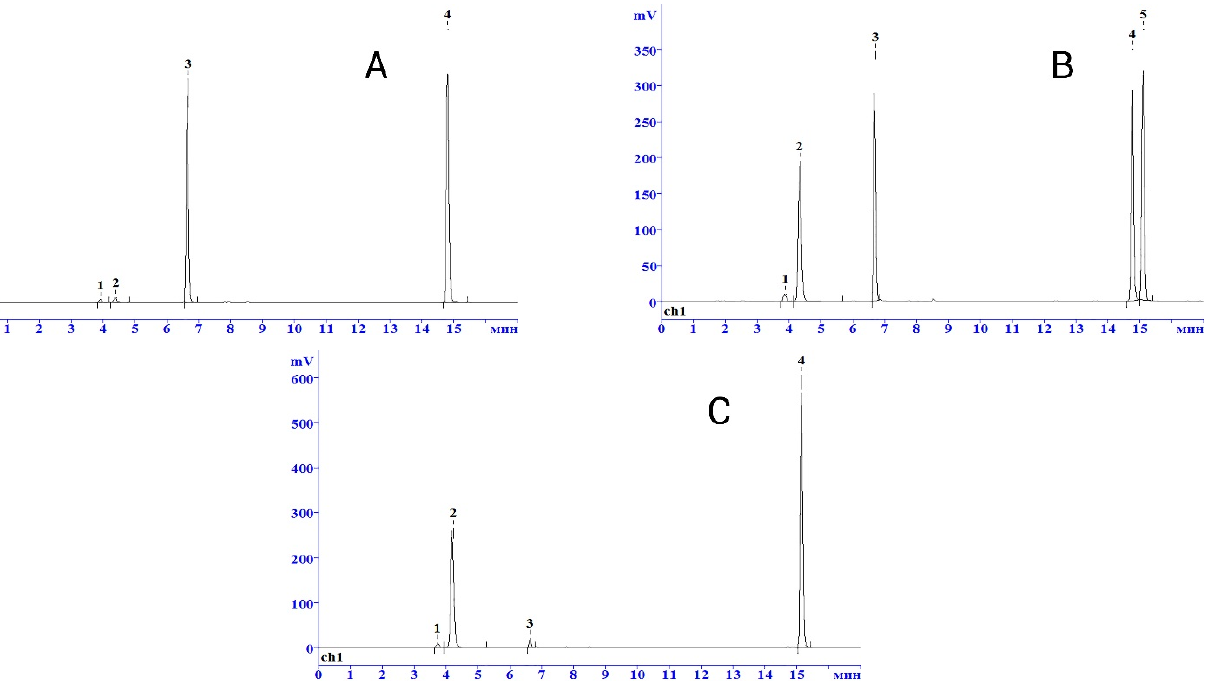
Figure 3. Preparative synthesis of N 6 -Fur-dAdo ( 6b ) using transglycosylation reaction. ( A ): t0, 2 – 7- MeGua, 3 –7-MedGuo ( 4 ), 5 – N 6 -Fur-Ade ( 3b ); (B ): 1 h, 2 –7-MeGua, 3 –7-MedGuo ( 4 ), 5 – N 6 -Fur-Ade ( 3b ), 7 – N 6 -Fur-dAdo ( 6b ); ( C ): 4 h, 2 –7-MeGua, 3 –7-MedGuo ( 4 ), 5 – N 6 -Fur-Ade ( 3b ), 7 – N 6 -Fur- dAdo ( 6b ); ( D ): 24 h, 2 –7-MeGua, 3 –7-MedGuo ( 4 ), 4 – N 6 -Fur-Ade ( 3b ), 7 – N 6 -Fur-dAdo ( 6b ).